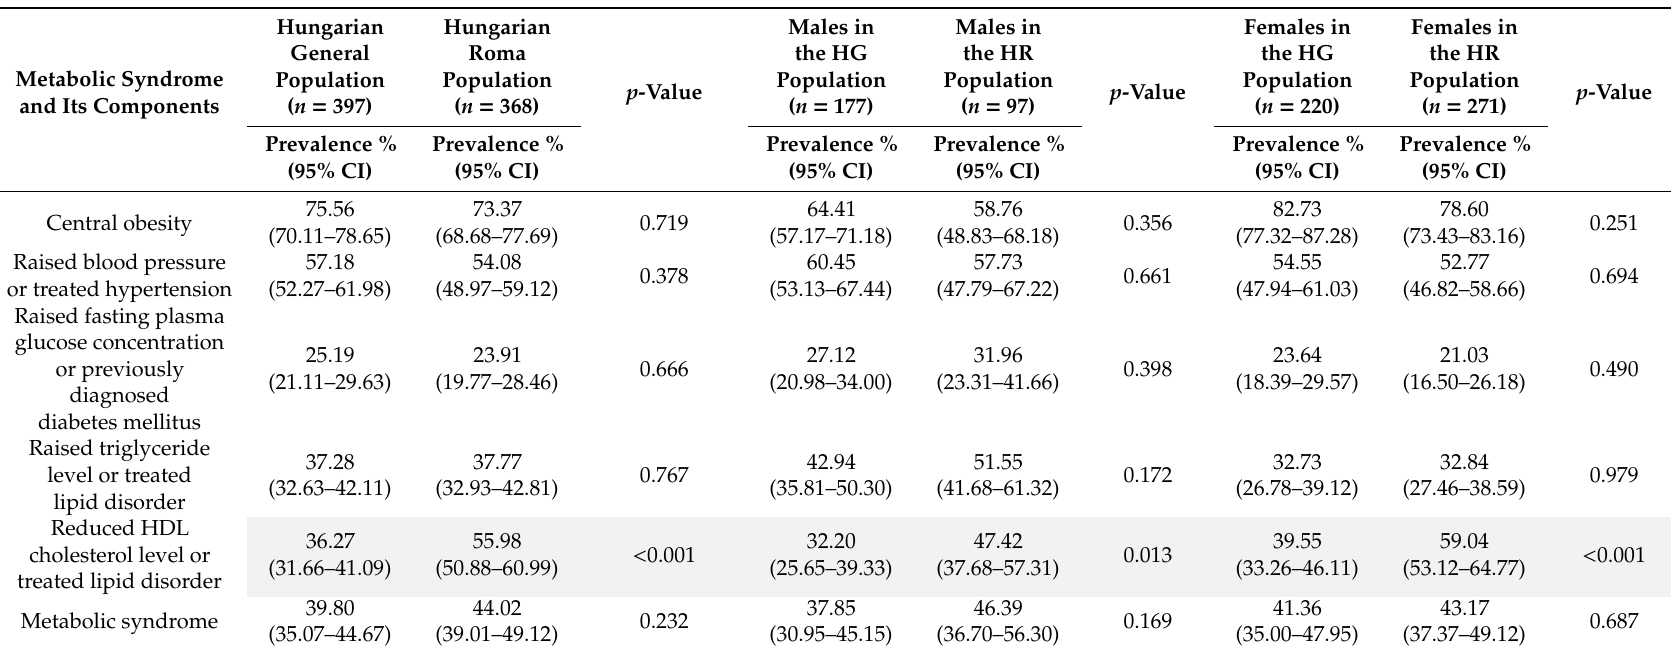
Table 2. Prevalence of metabolic syndrome and its components in the Hungarian general (HG) and Hungarian Roma (HR) populations by ethnicity and